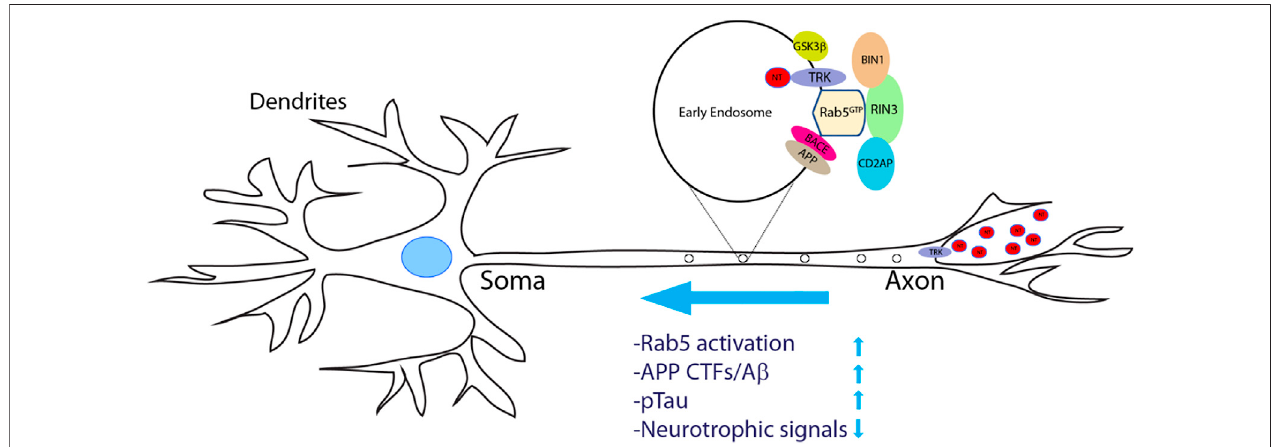
FIGURE 5 | A proposed model of increased RIN3 activity in disrupting axonal transport in Alzheimer ’ s Diseases. Neurotrophic factors (NTs) bind to and activate theirrespectivetyrosinereceptorkinases(TRKs)toformasignalcomplex,thatisinternalizedintoRab5+earlyendosomesforretrogradetransport.Increasedexpression ofRIN3ortheW63CvariantenhancesRab5activation,whichinturnpromotesAPPprocessingtoproducec-terminalfragments(CTFs)/A β inconjunctionwithCD2AP.In addition, RIN3/BIN1 increases phosphorylation of Tau. Consequently, retrograde transport of trophic signals (NT/Trk) is impaired leading to eventual neurodegeneration in AD.